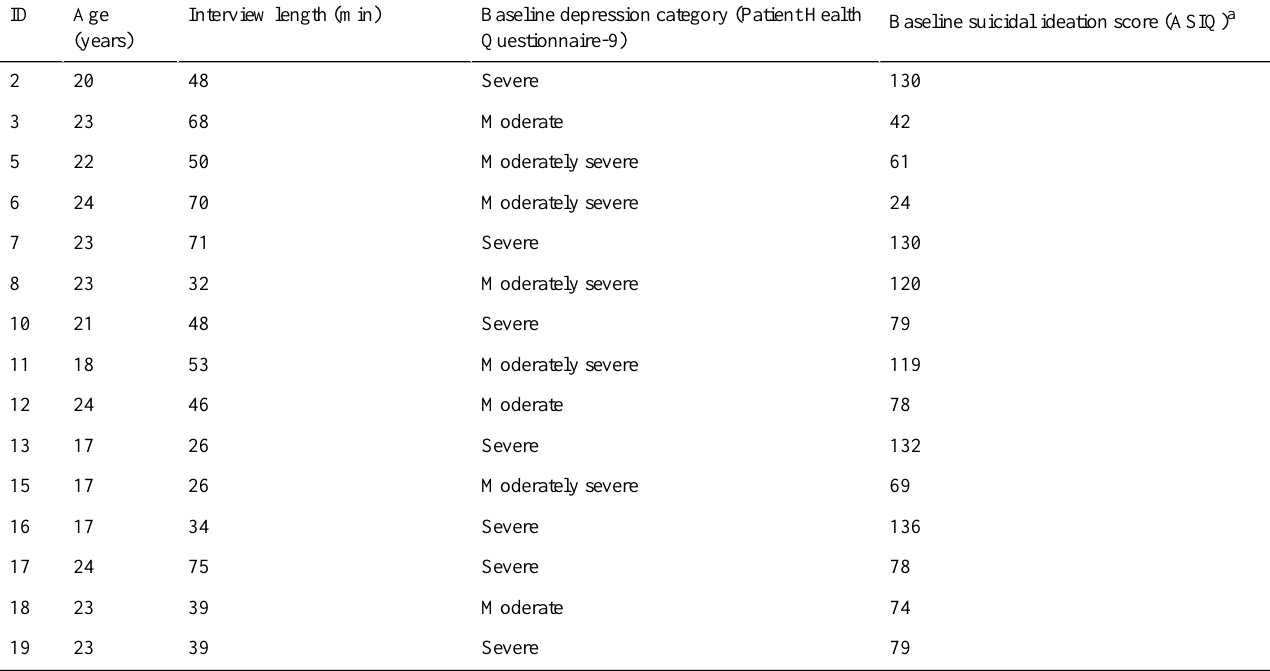
Table 1. Participant ID, age, interview length, and clinical characteristics at baseline